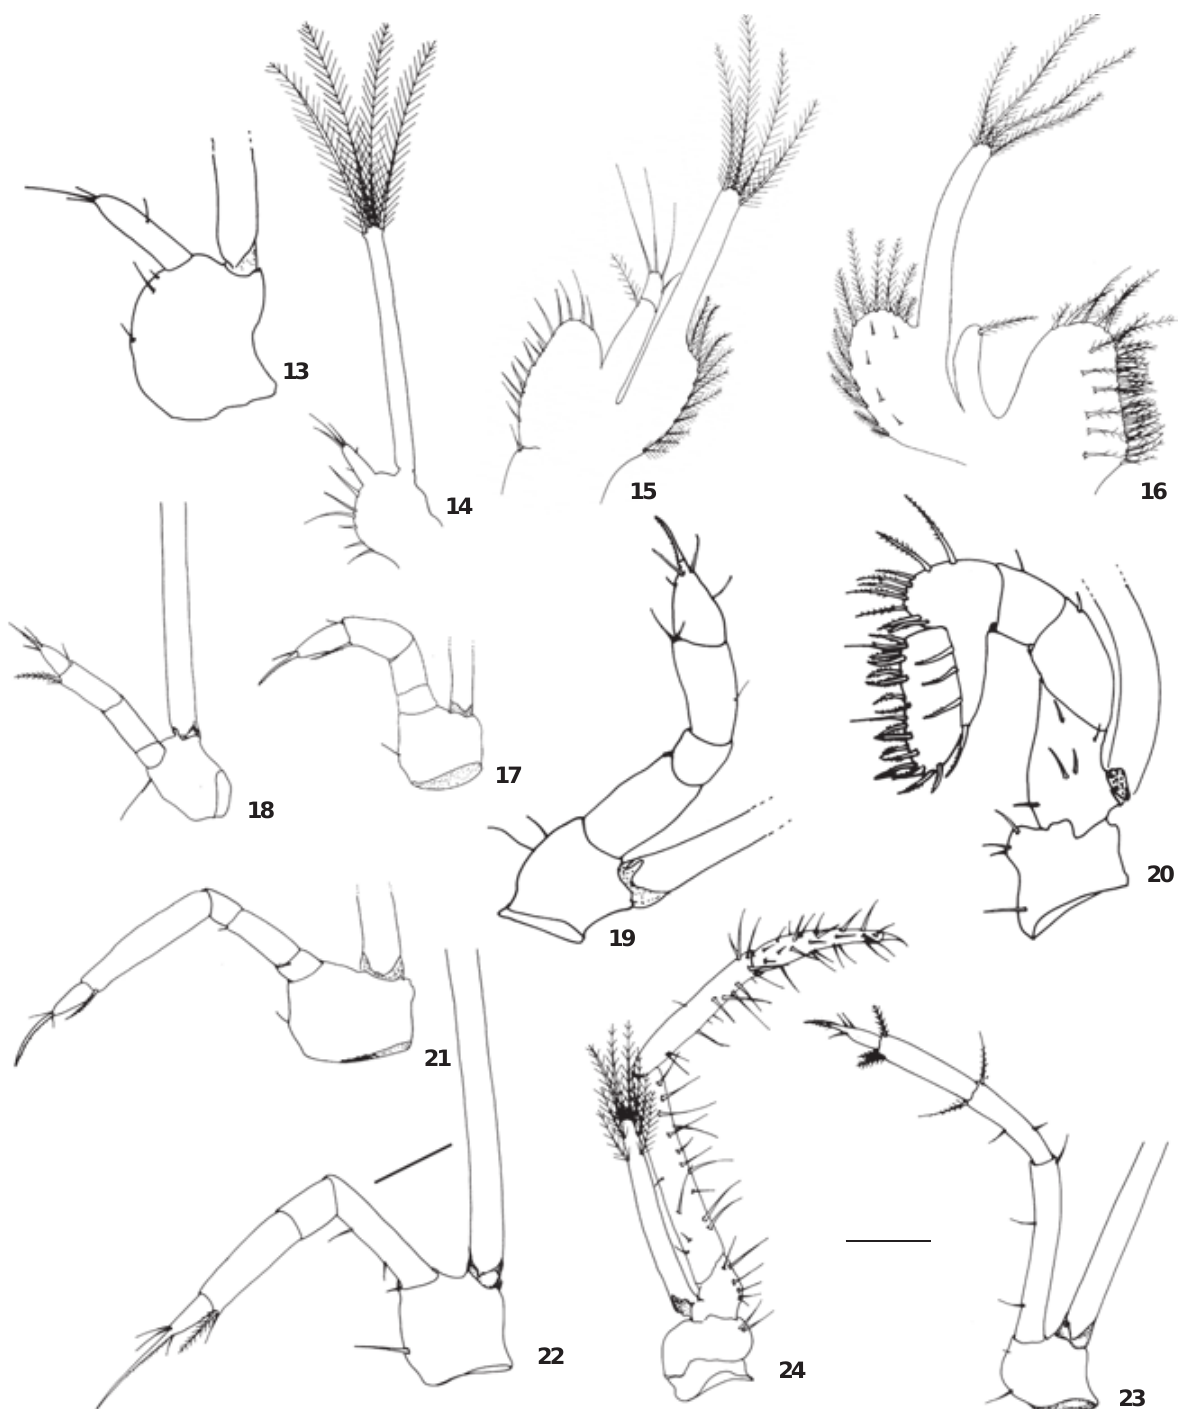
Figures 13-24. Mouthparts in M. amazonicum . (13-16) First maxillipeds: (13) zoea I; (14) zoea II; (15) zoea IX; (16) post-larva. (17-20) Second maxillipeds in M. amazonicum : (17) zoea I; (18) zoea II; (19) zoea IX, (20) post-larva. (21-24) Third maxillipeds in M. amazonicum